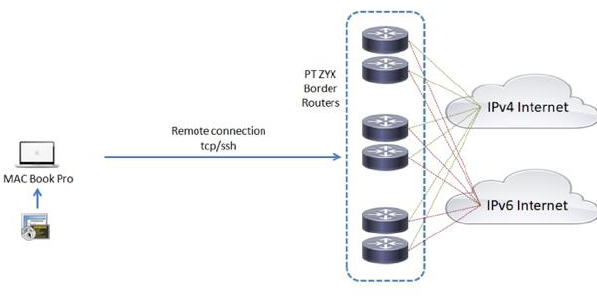
Fig. 9. Throughput and download time test environment